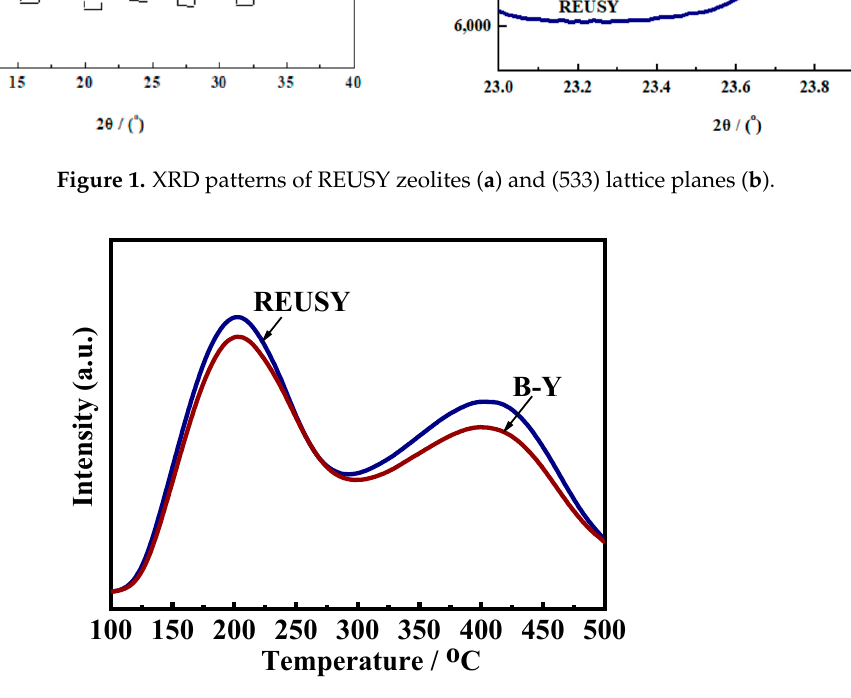
Figure 1. XRD patterns of REUSY zeolites ( a ) and (533) lattice planes ( b ).